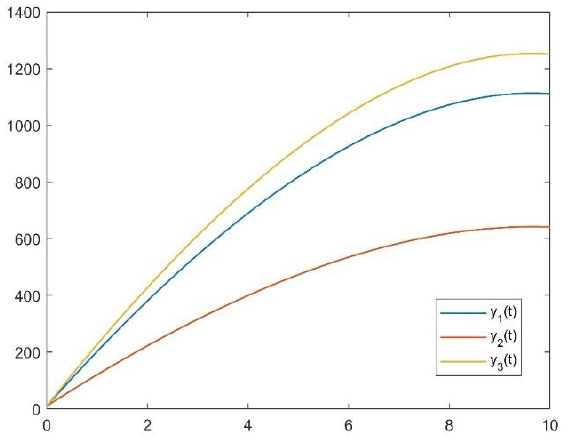
Figure 4. The optimal goodwill trajectories for all segments.